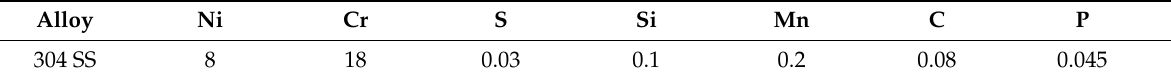
Table 1. Chemical composition of 304 stainless steel specimens (wt.%).